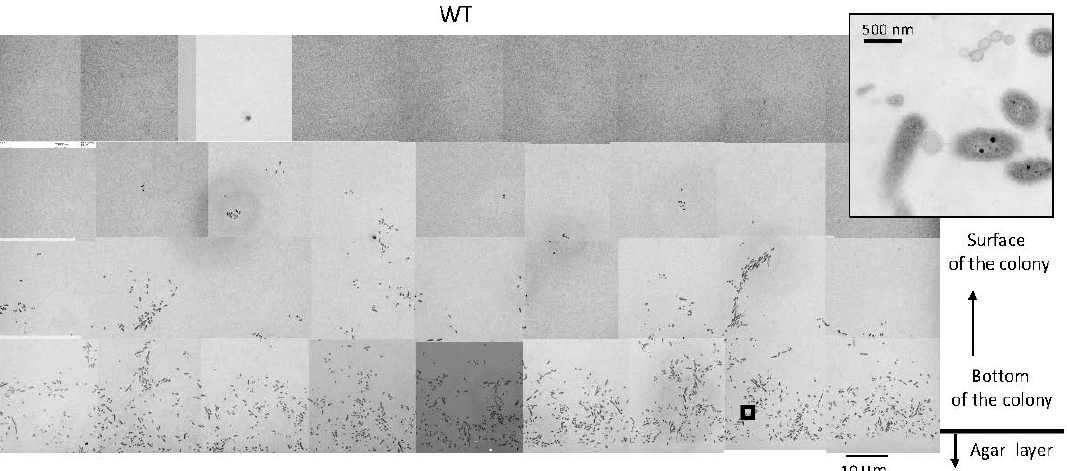
Figure 2. TEM of spreading colonies of WT F. johnsoniae on 1% A-PY2. WT colonies were aldehyde-fixed and embedded in Epon resin. Then, 70 nm-thick sections were cut parallel to the direction of colony growth and perpendicular to the surface of the agar medium (Figure S1b), stained with metal solutions and examined by TEM. Overview of the sections examined. High-magnification images of cells in Figure 2 are shown in Figure 7. Inset is the enlargement of the square in the left panel.